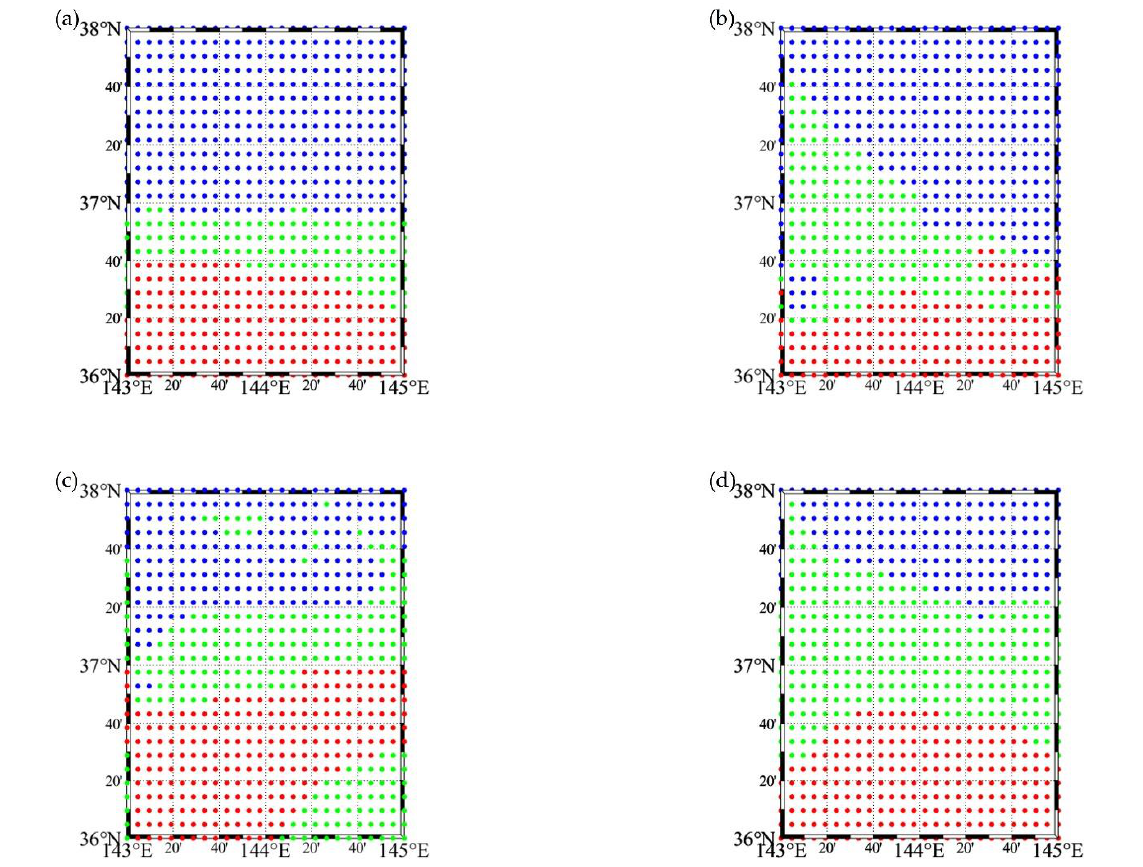
Figure 5. The results of clustering the surface sound speed of the study sea area via FCM (the blue points represent the north water mass of the frontal zone, the red points represent the south water mass of the frontal zone, and the green points represent the frontal transition water mass): ( a ) 1 January 2019; ( b ) 1 February 2019; ( c ) 1 July 2019; ( d ) 1 August 2019. The position, width, and range of the KEF are different at different times. Taking the experiment on the 144 ◦ E characteristic section as an example, the widths of the frontal zone at different times are 30 km, 60 km, 50 km, 70 km, respec- tively.